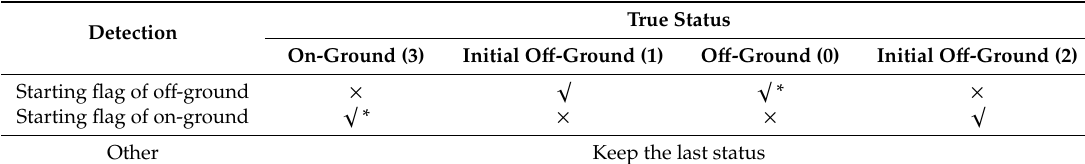
Table 1. Evaluation of detection with true